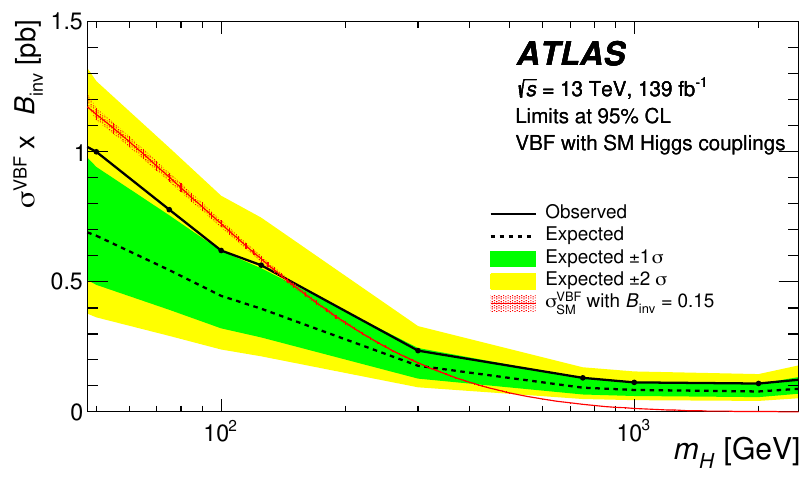
Figure 14. Upper limit on cross section times branching ratio to invisible particles for a scalar mediator as a function of its mass. For comparison the VBF cross section at NLO in QCD, i.e. without the electroweak corrections, for a particle with SM Higgs boson couplings, multiplied by a B inv value of 15%, is